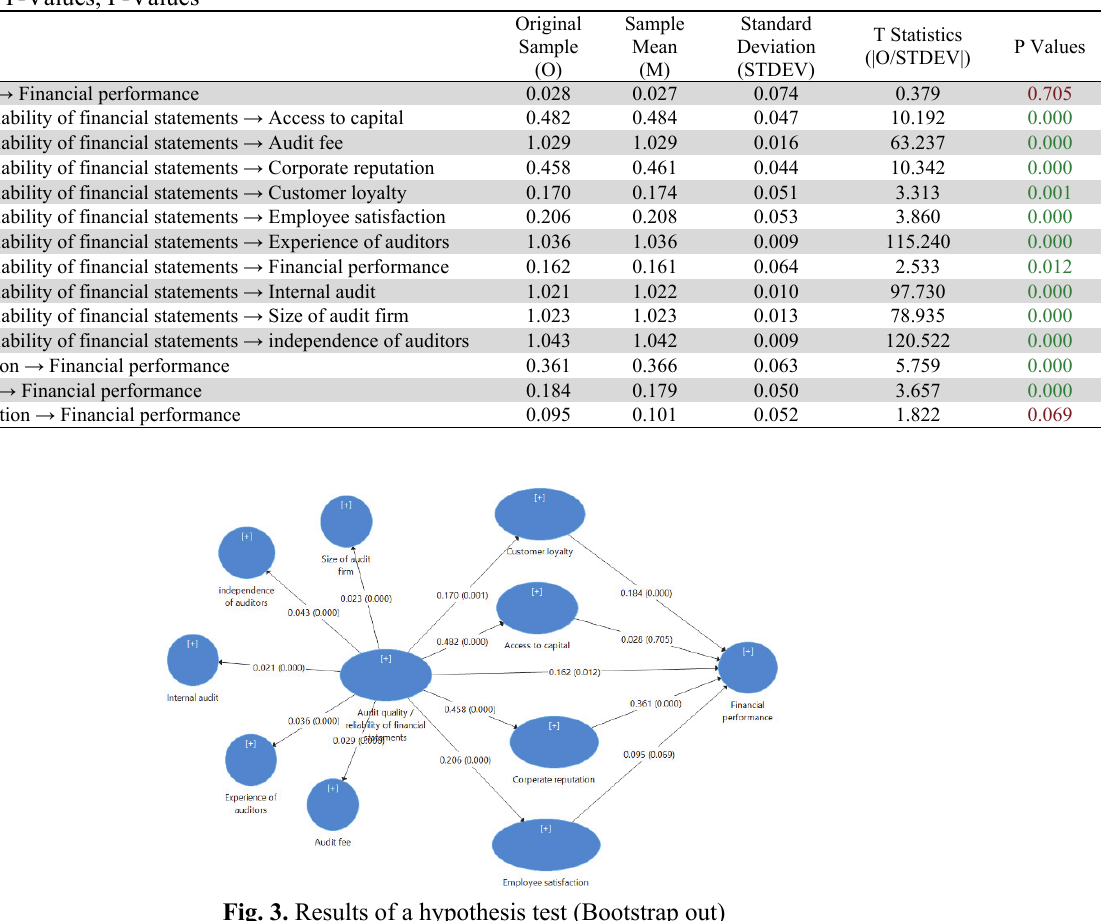
Path Coefficients